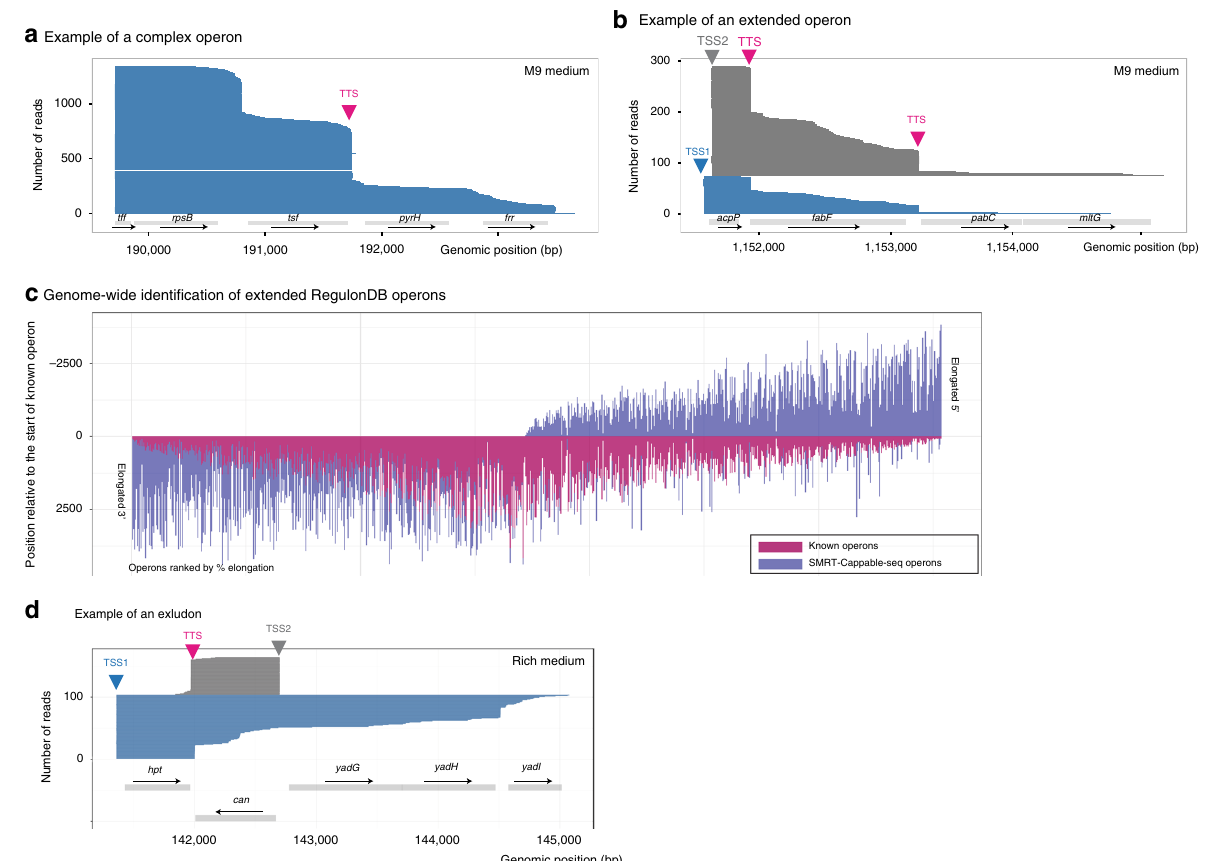
Fig. 2 Operons in E. coli . a An example of the tff-rpsB-tsf operon in RegulonDB elongated at its 3 ′ end with two additional genes: pyrH and frr . The x -axis represents the position (in bp) on the reference genome (NC_000913.3) and the y -axis represents individual mapped reads ordered by read size in ascending order. For clarity only reads from one TSS (position at 189712) are shown. Red arrow indicates the previously described Rho-independent terminator. tff encodes a putative small RNA. The product of pyrH is involved in nucleotide biosynthesis, while the products of r psB , tsf , and frr are involved in translation. b An example of extending the predicted operon acpP-fabF 18 with two additional genes: pabC and mltG . c Genome-wide distribution of elongated operons compared to RegulonDB with additional gene(s). Elongated operons are de fi ned by at least one SMRT-Cappable-seq read that covers the entire known operon and extends it to include at least one additional fully covered gene. Only the longest known operons were used, and sub-operons fully included in the longest operons were excluded from this analysis. Each line corresponds to the size of the operons (in bp) with the previously annotated operons in pink and the extended operons in blue. Positions are relative to the 5 ′ end of the annotated operon with 0 being the TSS of the annotated operons. In total there are 883 RegulonDB operons extended by SMRT-Cappable-seq from either 5 ′ or 3 ′ end or both. d An example of an excludon. The transcripts encoding the can gene in the sense direction (gray) overlap with the transcripts (blue) containing the entire can gene in the antisense direction. Both transcripts share a bidirectional terminator (red arrow) with differential read-through where the majority (93%) of antisense transcript coding for the can gene terminates while the majority (85%) of the transcripts coding for hpt has